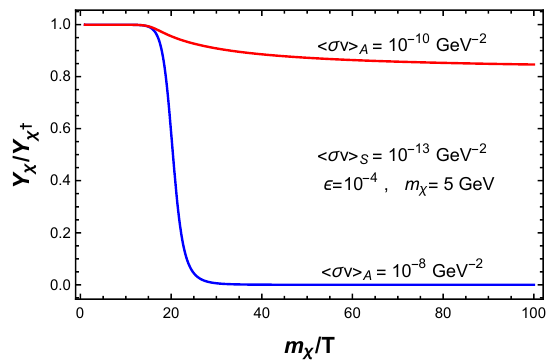
Figure 6 . Variation of the ratio of dark matter and anti-dark matter yields, Y (cid:31) =Y of m (cid:31) =T , for di(cid:11)erent values of the pair-annihilation rate, (cid:27)v and = 10 (cid:0) 8 GeV (cid:0) 2 (blue solid line), with (cid:12)xed values of m (cid:31) , h i A